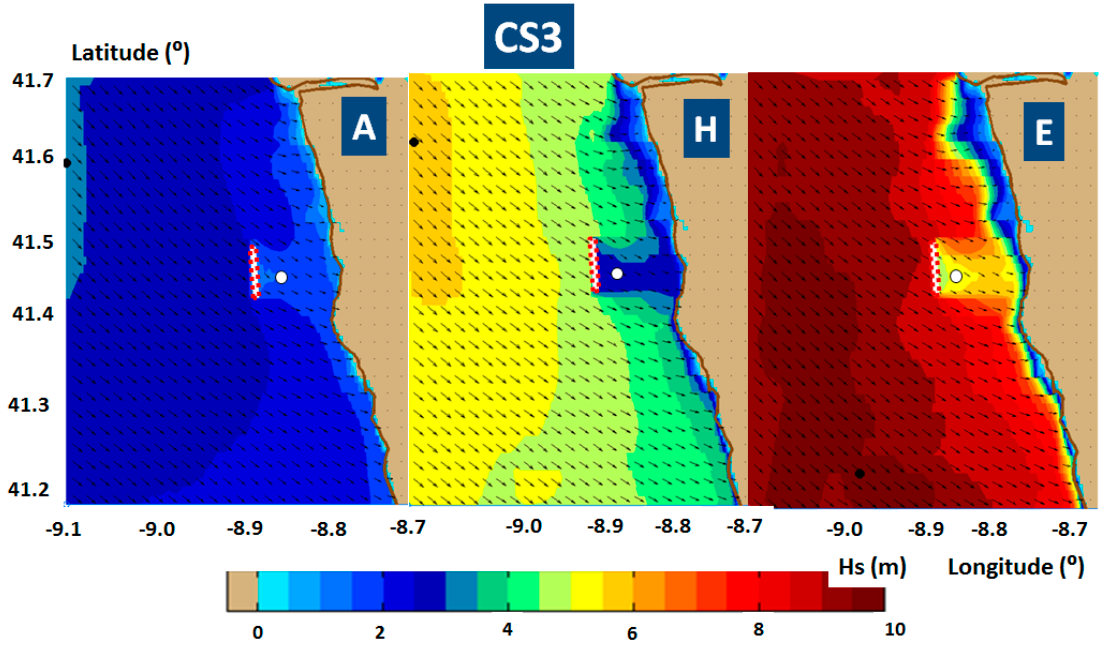
Figure 8. CS3 (optimistic scenario for the wave farm), results of the SWAN model simulations. The significant wave height scalar fields are represented in the background, while in the foreground the wave vectors. A—average wave conditions, H—high wave conditions, E—extreme wave conditions.